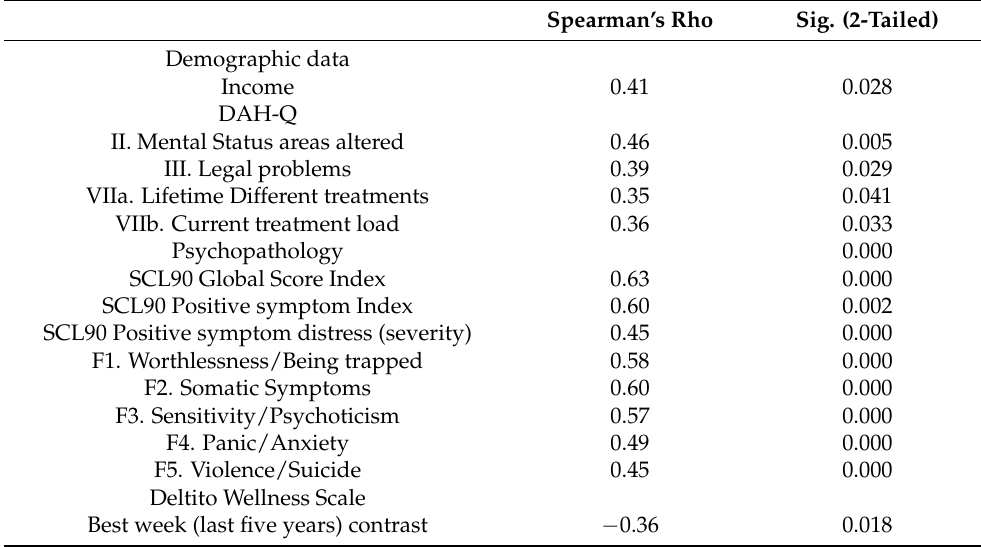
Table 1. Bivariate correlation between the severity of stress sensitivity and other clinical aspects (only significant correlations were